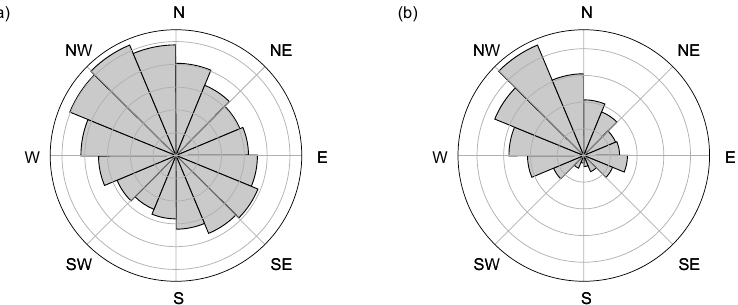
Figure 4. Slope orientation of ( a ) the whole study area and ( b ) the area observed by